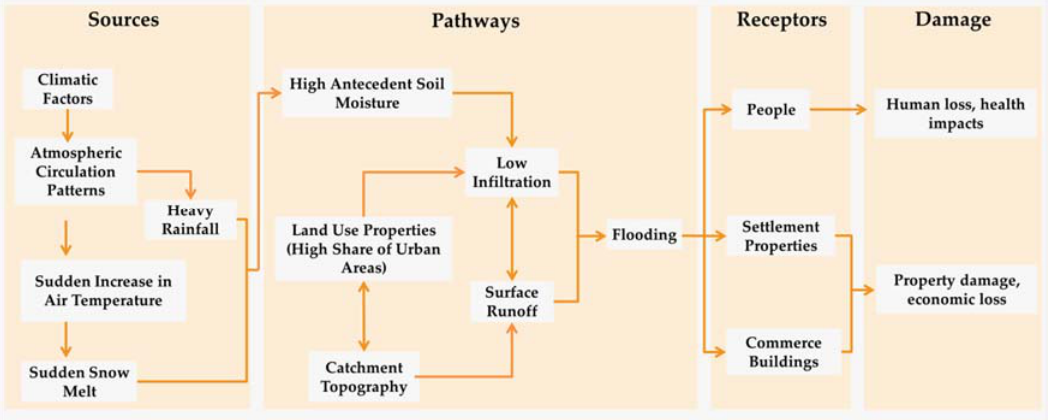
Figure 1. Conceptualized Source–Pathway–Receptor–Consequence (SPRC) model diagram for analyzed flood events (adapted from Sayers et al. [22]).